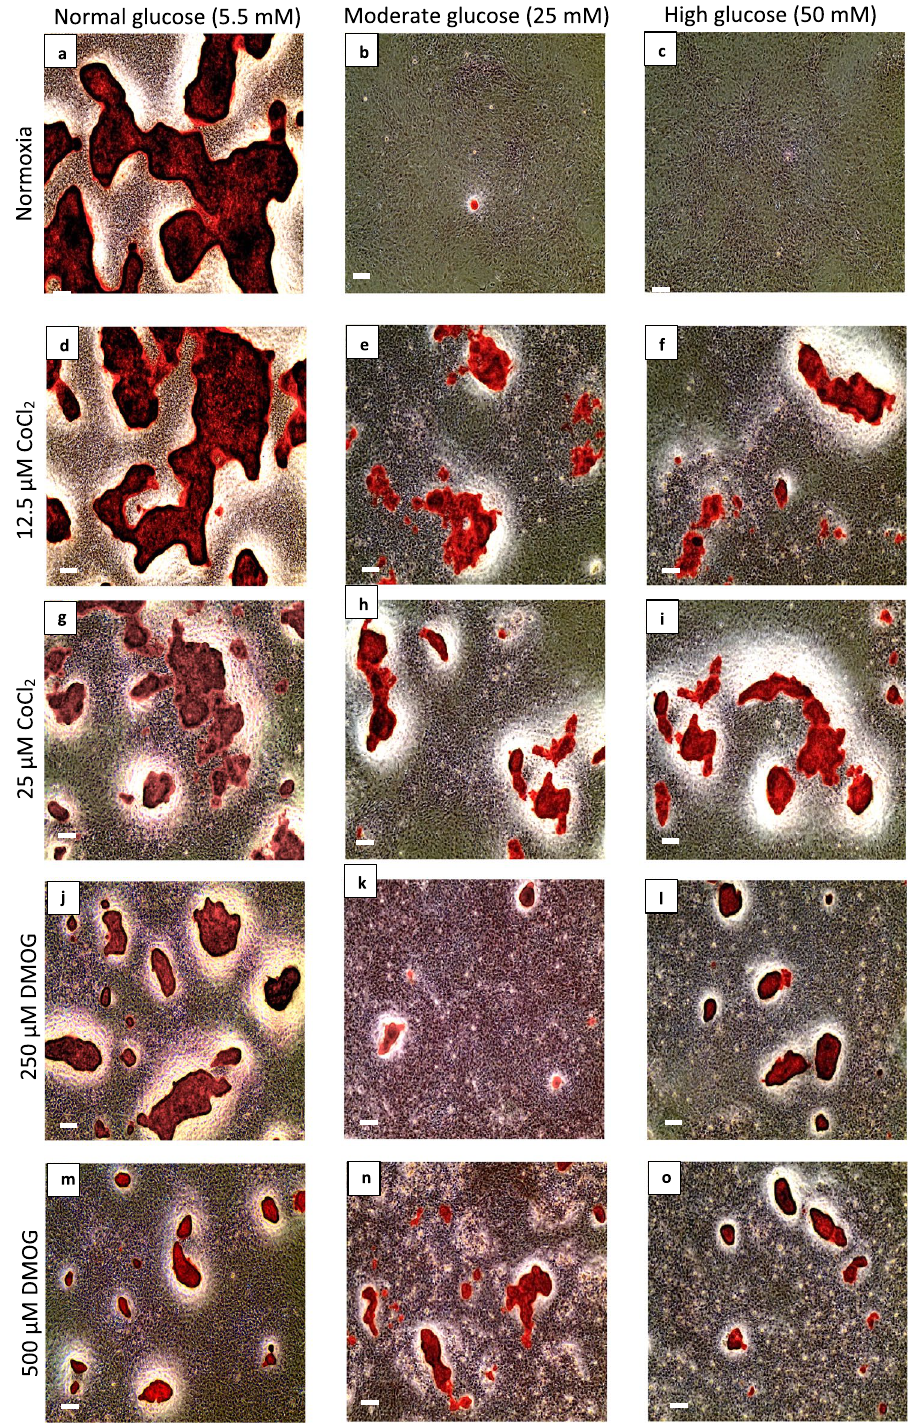
Figure 3. CoCl 2 and DMOG restored nodule formation in hyperglycaemic cultured osteoblasts. After 21 days, Alizarin Red staining (ARS) showed bone nodule formation in untreated cultures in ( a ) normal glucose (5.5 mM), whilst the addition of ( b ) moderate (25 mM) and ( c) high glucose (50 mM) inhibited nodule formation. ( d – o ) Cultures treated with hypoxia mimetics CoCl 2 and DMOG decreased bone nodule formation in normal glucose levels but increased bone nodule formation in moderate and high glucose levels compared to untreated controls. Scale bar for all images is 200 µm. (n =